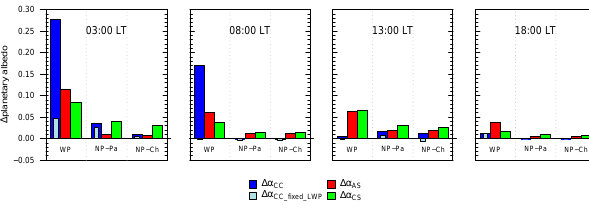
Fig. 7. Domain and time averaged albedo perturbations associated with aerosol injection at the SA0.5 rate, at 03:00:00 LT, 08:00:00 LT, 13:00:00 LT and 18:00:00 LT into the weakly precipitating regime (WP) and non-precipitating regime (NP-Pa and NP-Ch). In each case, four measures of the effects of aerosol injection on albedo perturbations are shown: the change in cloud albedo ( 1α CC ) ; the change in cloud albedo assuming a LWP fixed at the control magni- tudes with weighted N d increases ( 1α CC fixed LWP ) ; the change in all-sky planetary albedo ( 1α AS ) ; and the change in clear-sky albedo ( 1α CS ) .